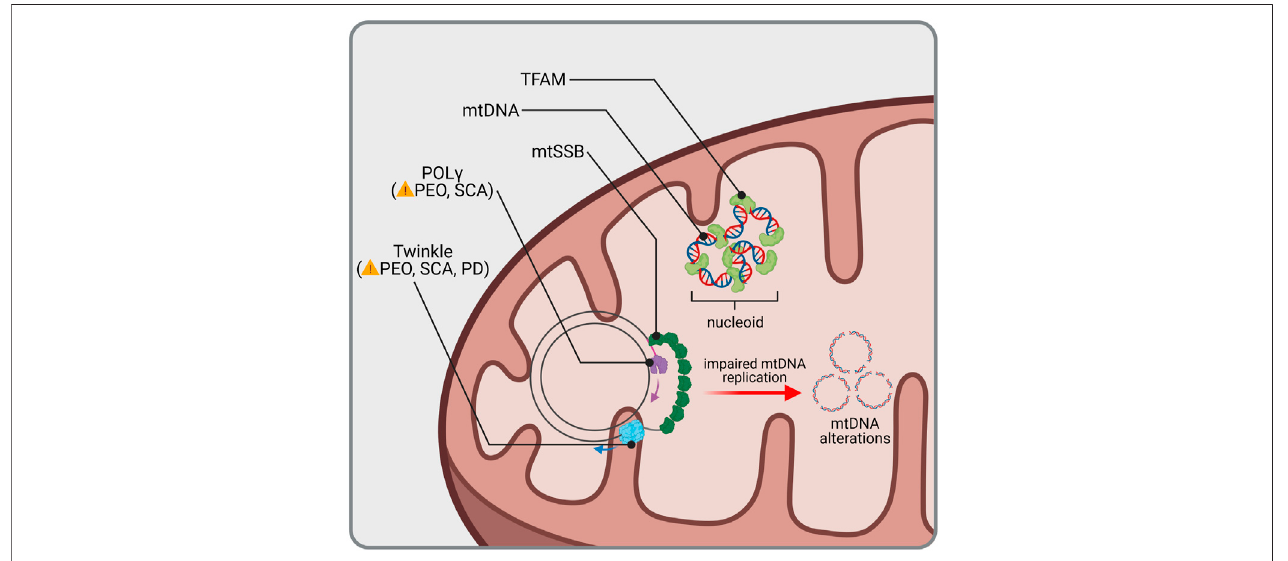
FIGURE 1 | mtDNA homeostasis and related diseases. mtDNA is protected and condensed by TFAM, building an organized DNA-protein complex known as nucleoid. Replication ofmtDNA requires coordination ofthe mitochondrial helicase Twinkleand DNApolymerase γ (POL γ ).Mutationsingenesencoding forTwinkleand POL γ lead to Progressive External Ophthalmoplegia (PEO), Spinocerebellar Ataxia (SCA) and Parkinsonism (PD). Impaired mtDNA replication is accompanied with mtDNA alterations, such as loss of wild type mtDNA or accumulation of mtDNA deletions, which have not only been found in rare or common diseases but also during